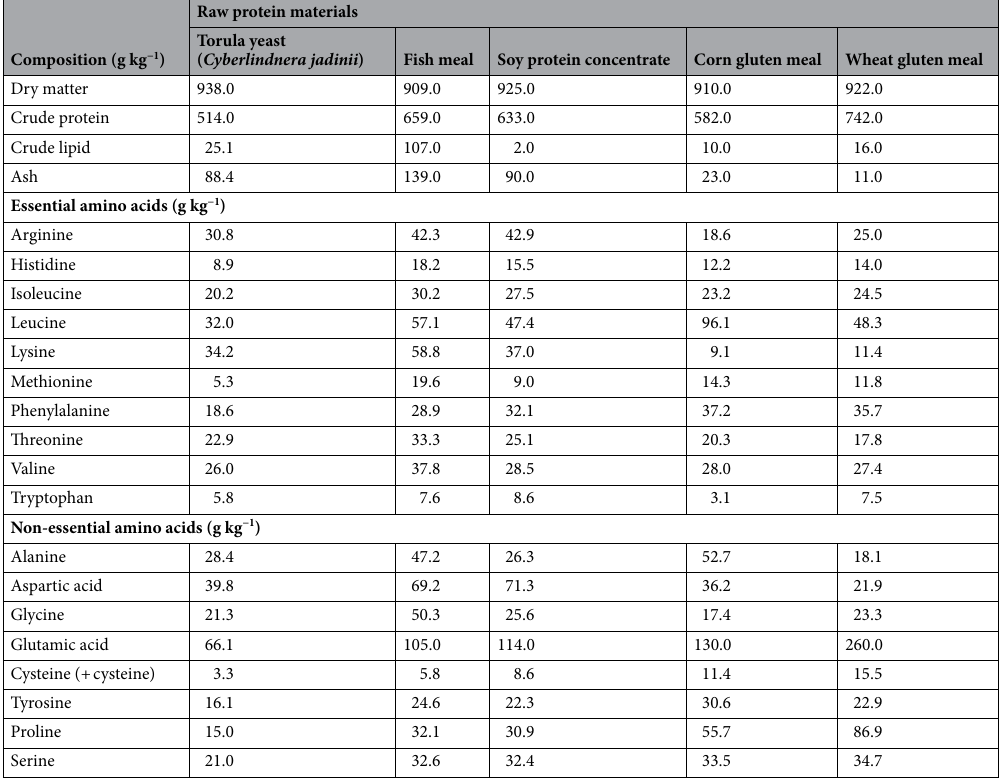
Table 3. Chemical composition of the protein sources used in feed treatments of this